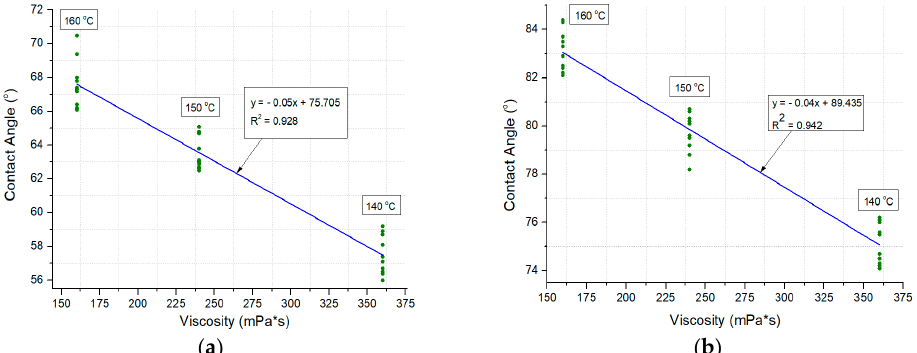
Figure 7. The correlations between the viscosity and contact angle values in mineral–asphalt mixtures: ( a ) WC-1; ( b )